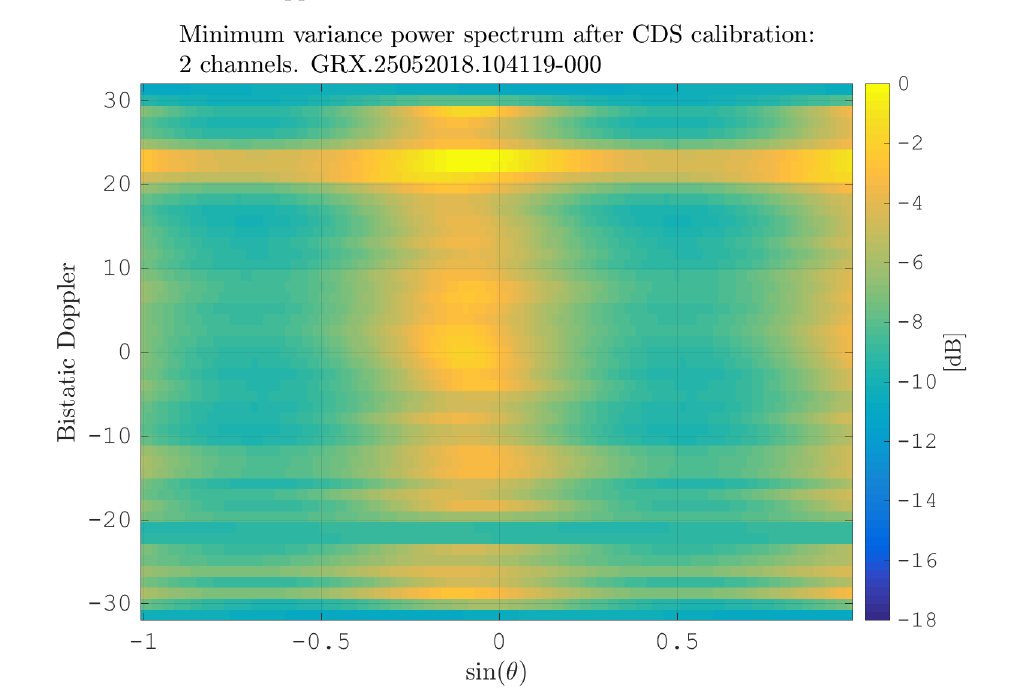
Figure 13. MV power spectrum after flex-DPCA and calibration using